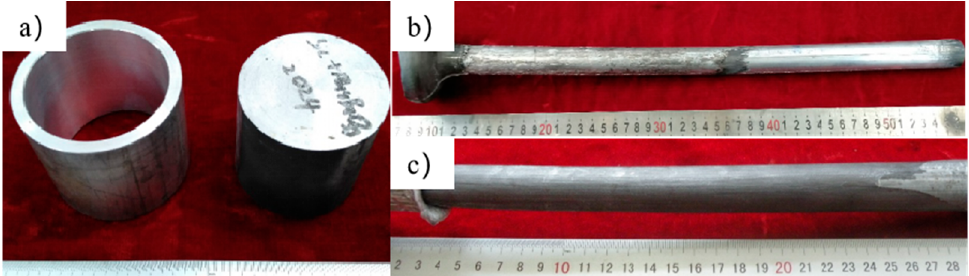
Figure 2. The billet and extruded bars of sheathed extrusion: ( a ) The billet of aluminum matrix com- posite with the size of φ 60 mm × 60 mm and the pure aluminum sheath; ( b ) The surface of SiCw + ϕ 60 mm × 60 mm and the pure aluminum sheath; ( b ) The surface of SiCw + Al 18 B 4 O 33 w/2024Al composite extruded bars Al 18 B 4 O 33 w/2024Al composite extruded bars by sheathed extrusion; ( c ) The surface of SiCw + by sheathed extrusion; ( c ) The surface of SiCw + Al 18 B 4 O 33 w/2024Al composite extruded bars by sheathed extrusion after Al 18 B 4 O 33 w/2024Al composite extruded bars by sheathed extrusion after removing the sheath. removing the